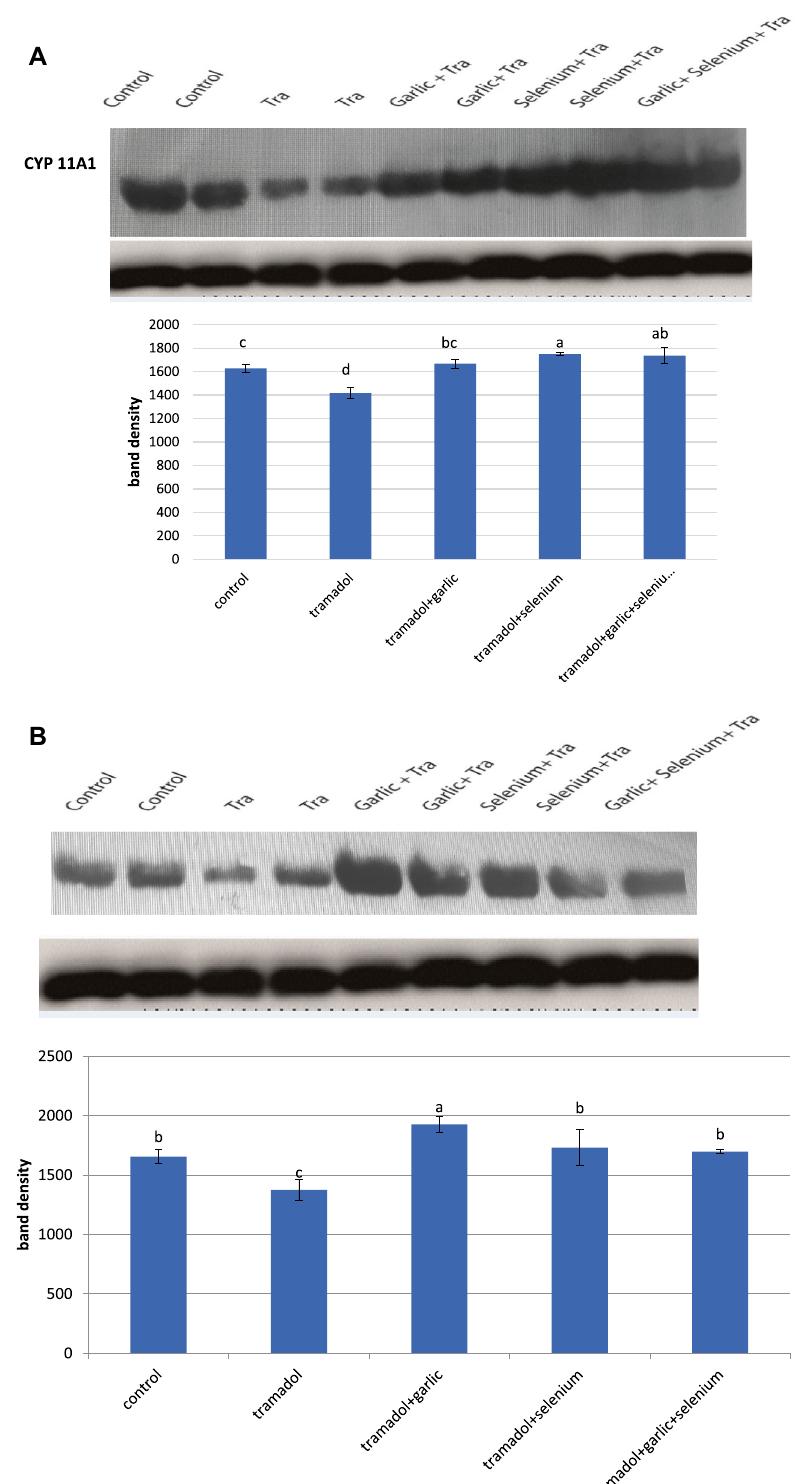
Figure 1. Western blot analysis showed the changes in CYP11A1 ( A ), CYP21A1 ( B ), CYP19 ( C ) protein expression after treatment of rabbits for 12 weeks with Tramadol (2 lanes), Tramadol + garlic (2 lanes), Tramadol + selenium (2 lanes), Tramadol + garlic + selenium (1 lane). ( B ) Quantification of the band density of each protein band was expressed in the histogram and columns with various letters are statistically significant [ P <